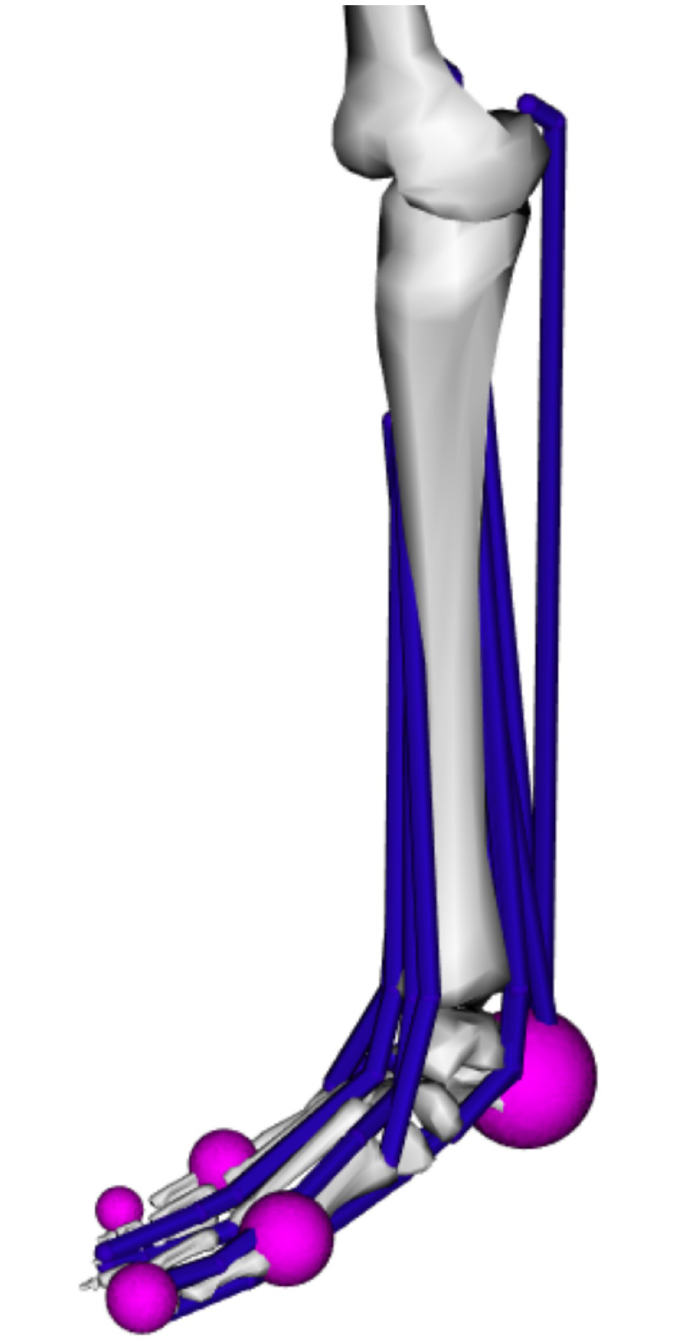
Fig 2. Foot model overview. Modified lower limb model of an arched foot truncated at the femur with nine extrinsic muscles (blue) and five spheres (pink) for generating contact with a moving ground